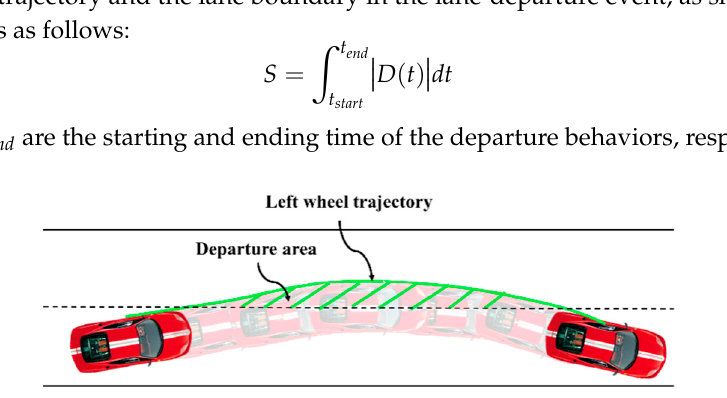
Figure 5. Illustration of departure area.